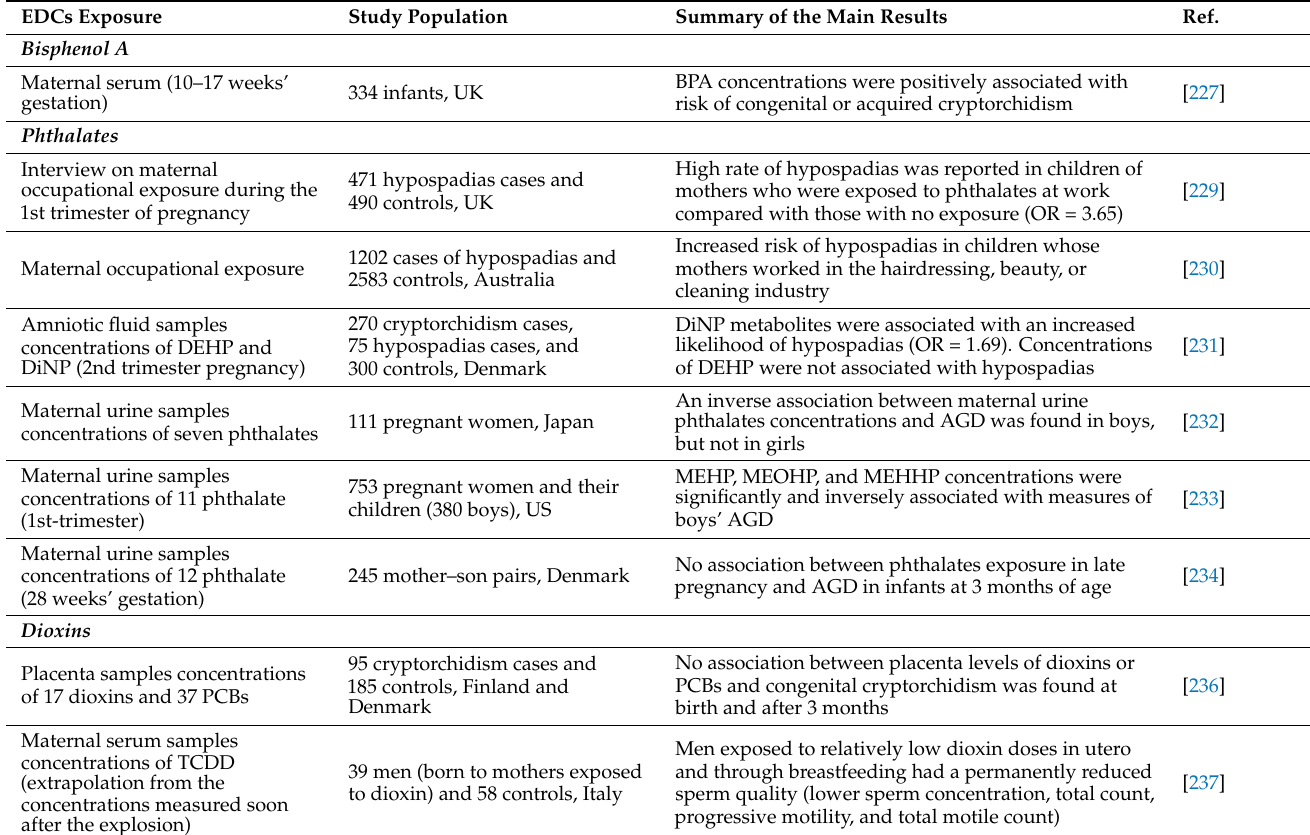
Table 6. Epidemiological data from some studies on male reproductive